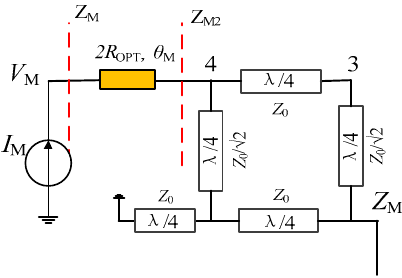
Figure 7. Improved main PA branch.